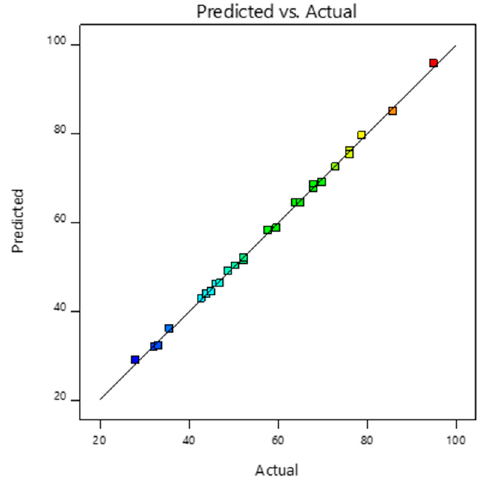
Figure 7. Plot of the experimental and predicted response obtained for photocatalytic degradation of MO using Gd 2 O 3 -ZIF-8 nanocomposites. Table 4. ANOVA of the BBD quadratic polynomial model for photocatalytic degradation of MO using Gd 2 O 3 -ZIF-8 nanocomposites.